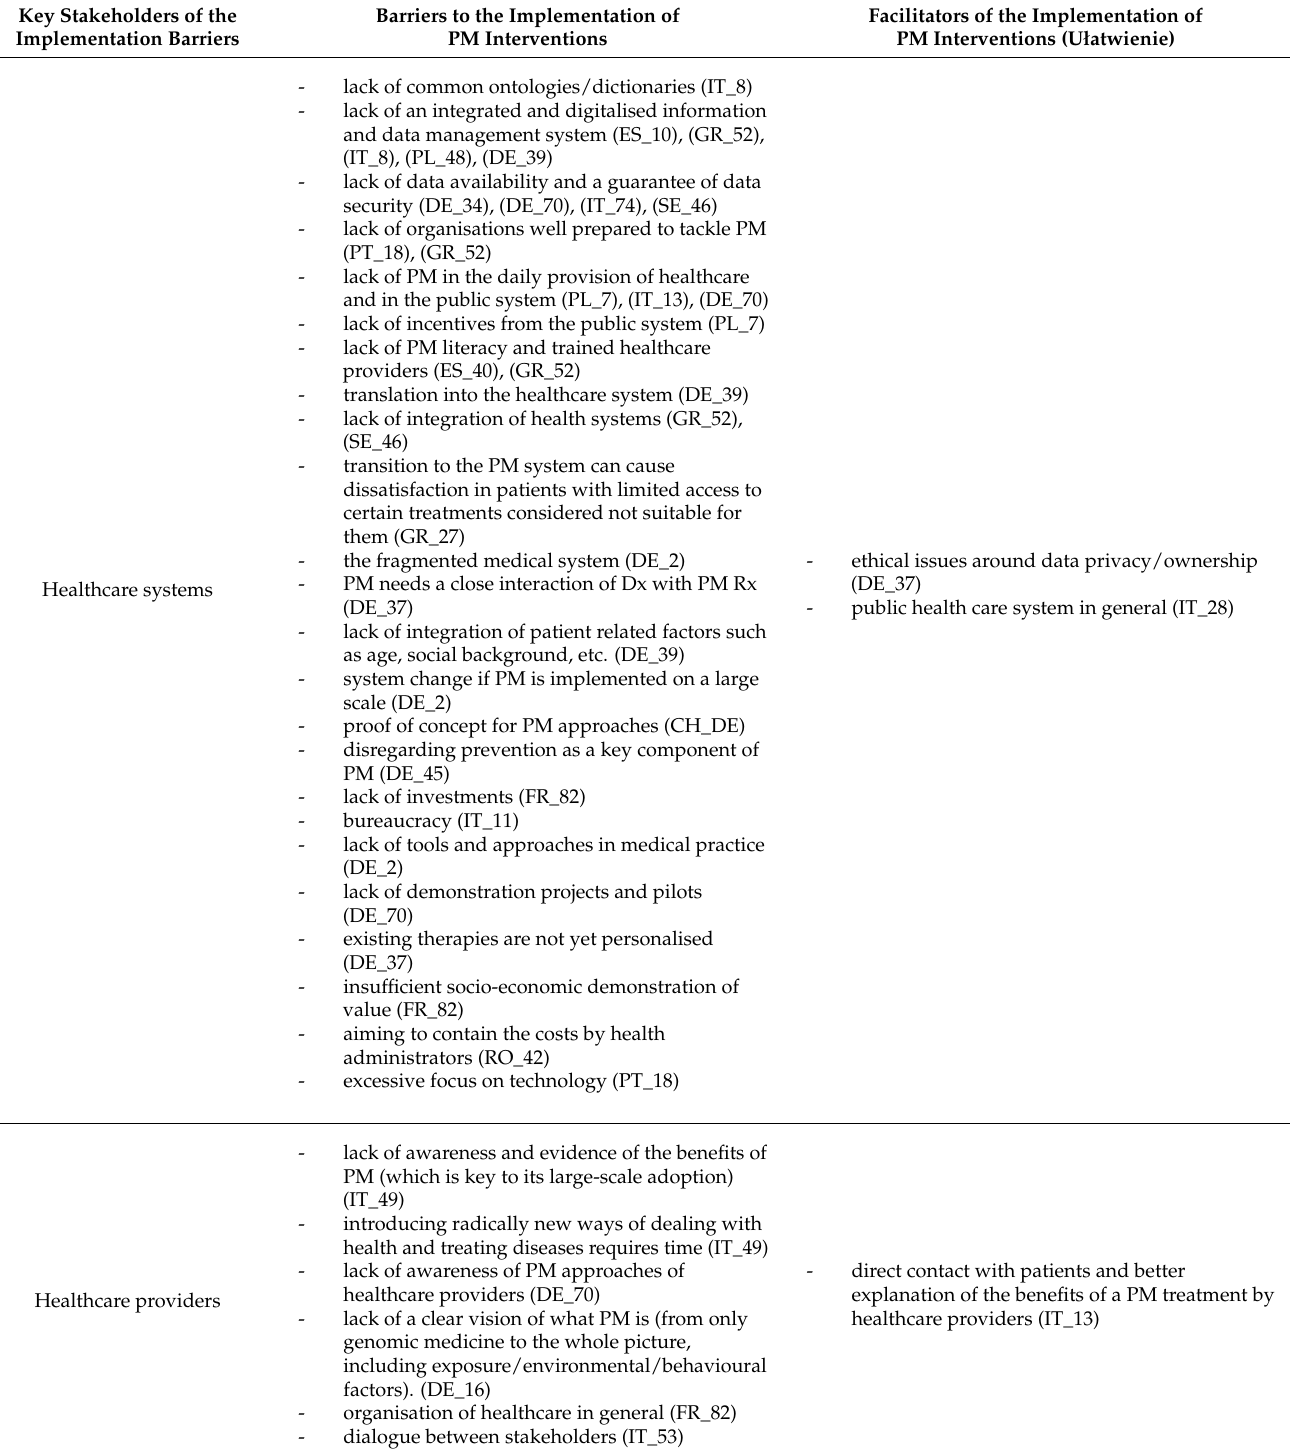
Barriers to the Implementation of PM Interventions